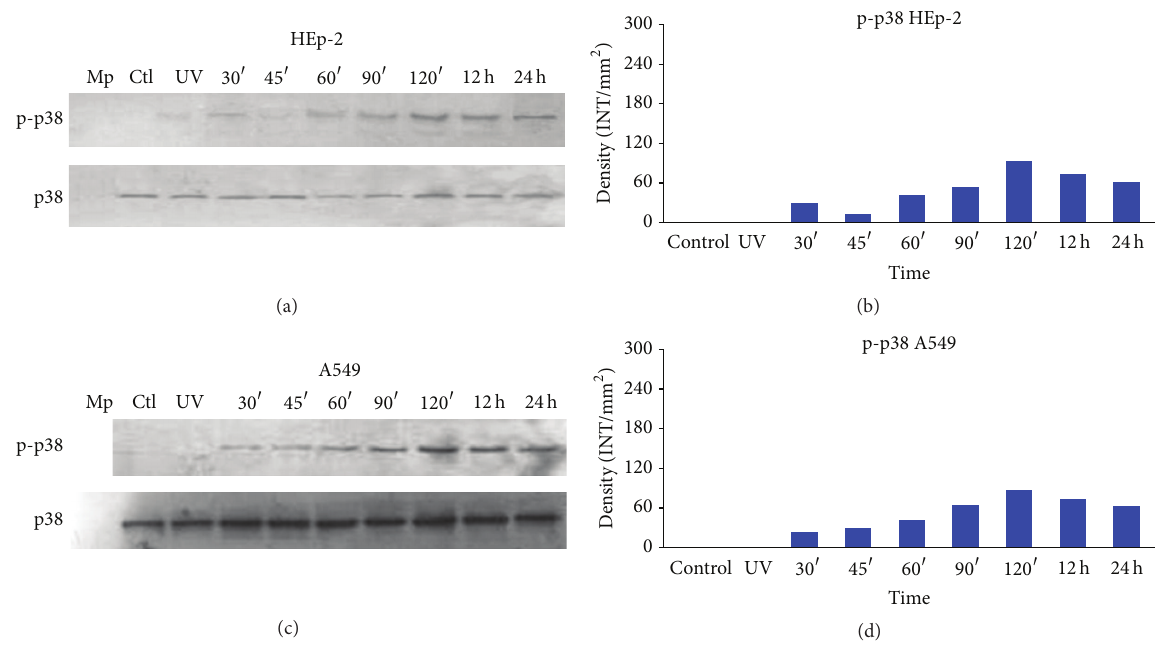
Figure 7: p38 phosphorylation. Detection of p38 phosphorylation in HEp-2 and A549 cells infected with HPIV-1. Cells were infected with live and inactivated HPIV-1 at different time points, and p38 phosphorylation was detected. Whole cell lysates were prepared for Western blotting (as described in Materials and Methods) to detect the phosphorylated (active) forms of the kinases. (a) Total protein concentrations in HEp-2 cells. Phospho-p38 was detected with monoclonal antibody sc-7973 and the total p38 sc-535 in HEp-2 cells; (b) densitometric analysis of p38 protein concentrations; (c) phospho-p38 and total protein concentrations in A549 cells; (d) densitometric analysis of the protein concentrations. Mp: molecular weight; CTL: control and UV (inactive virus) that corresponds to 12 hours in path 3. Data are the means for triplicate measurements from the three separate experiments.